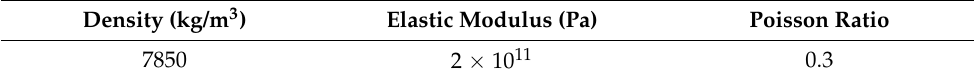
Table 1. The main structural material parameters of the large headframe.